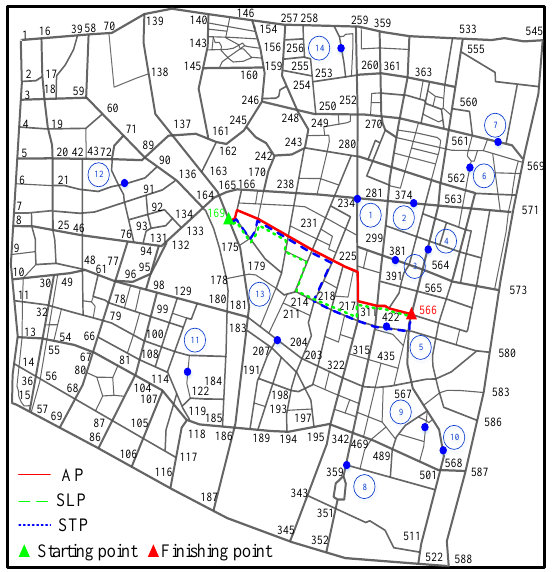
Figure 8. Comparison of routes searched by Actual Path, Shortest Length Path and Shortest Time Path STP.